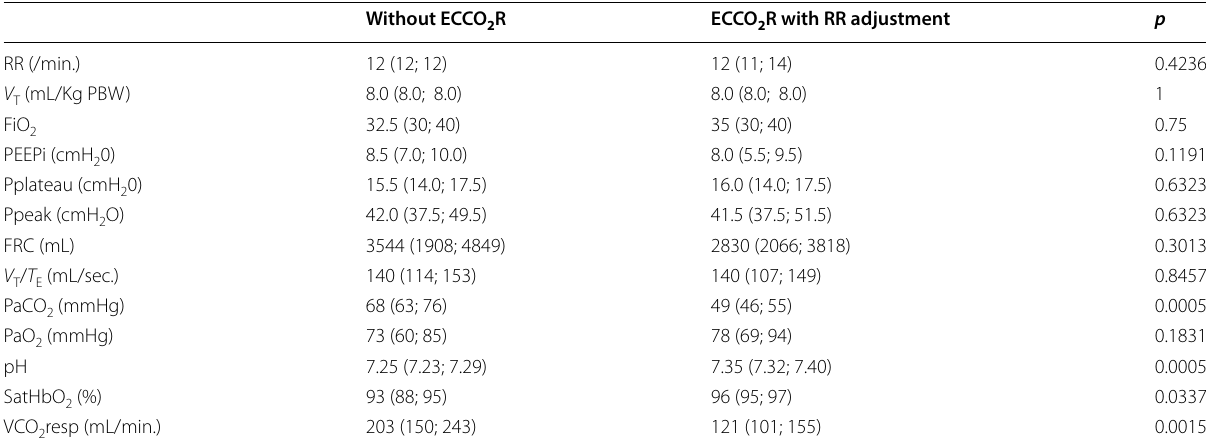
R and after ECCO R initiation combined with RR adjustment 2 2